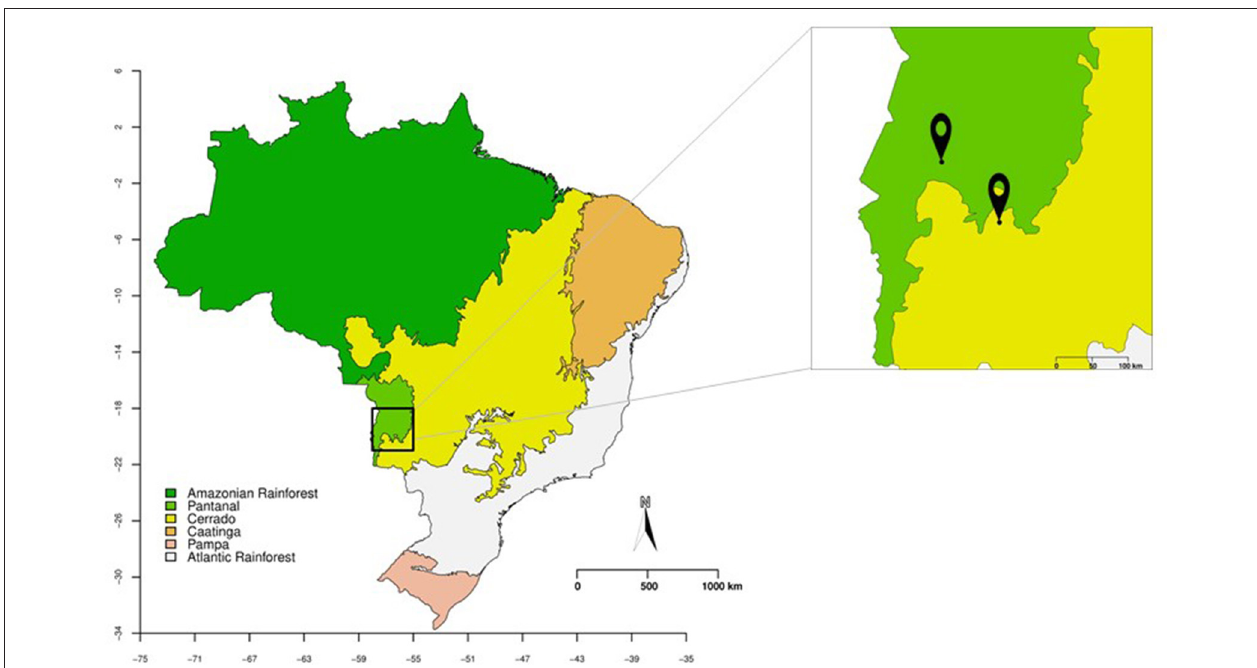
FIGURE 1 | Brazil map showing the Pantanal (in green) and Cerrado (in yellow) biomes. In the magnified box are represented the collecting points of leaves and petioles of Vochysia divergens (Pantanal) and Stryphnodendron adstringens (Cerrado).